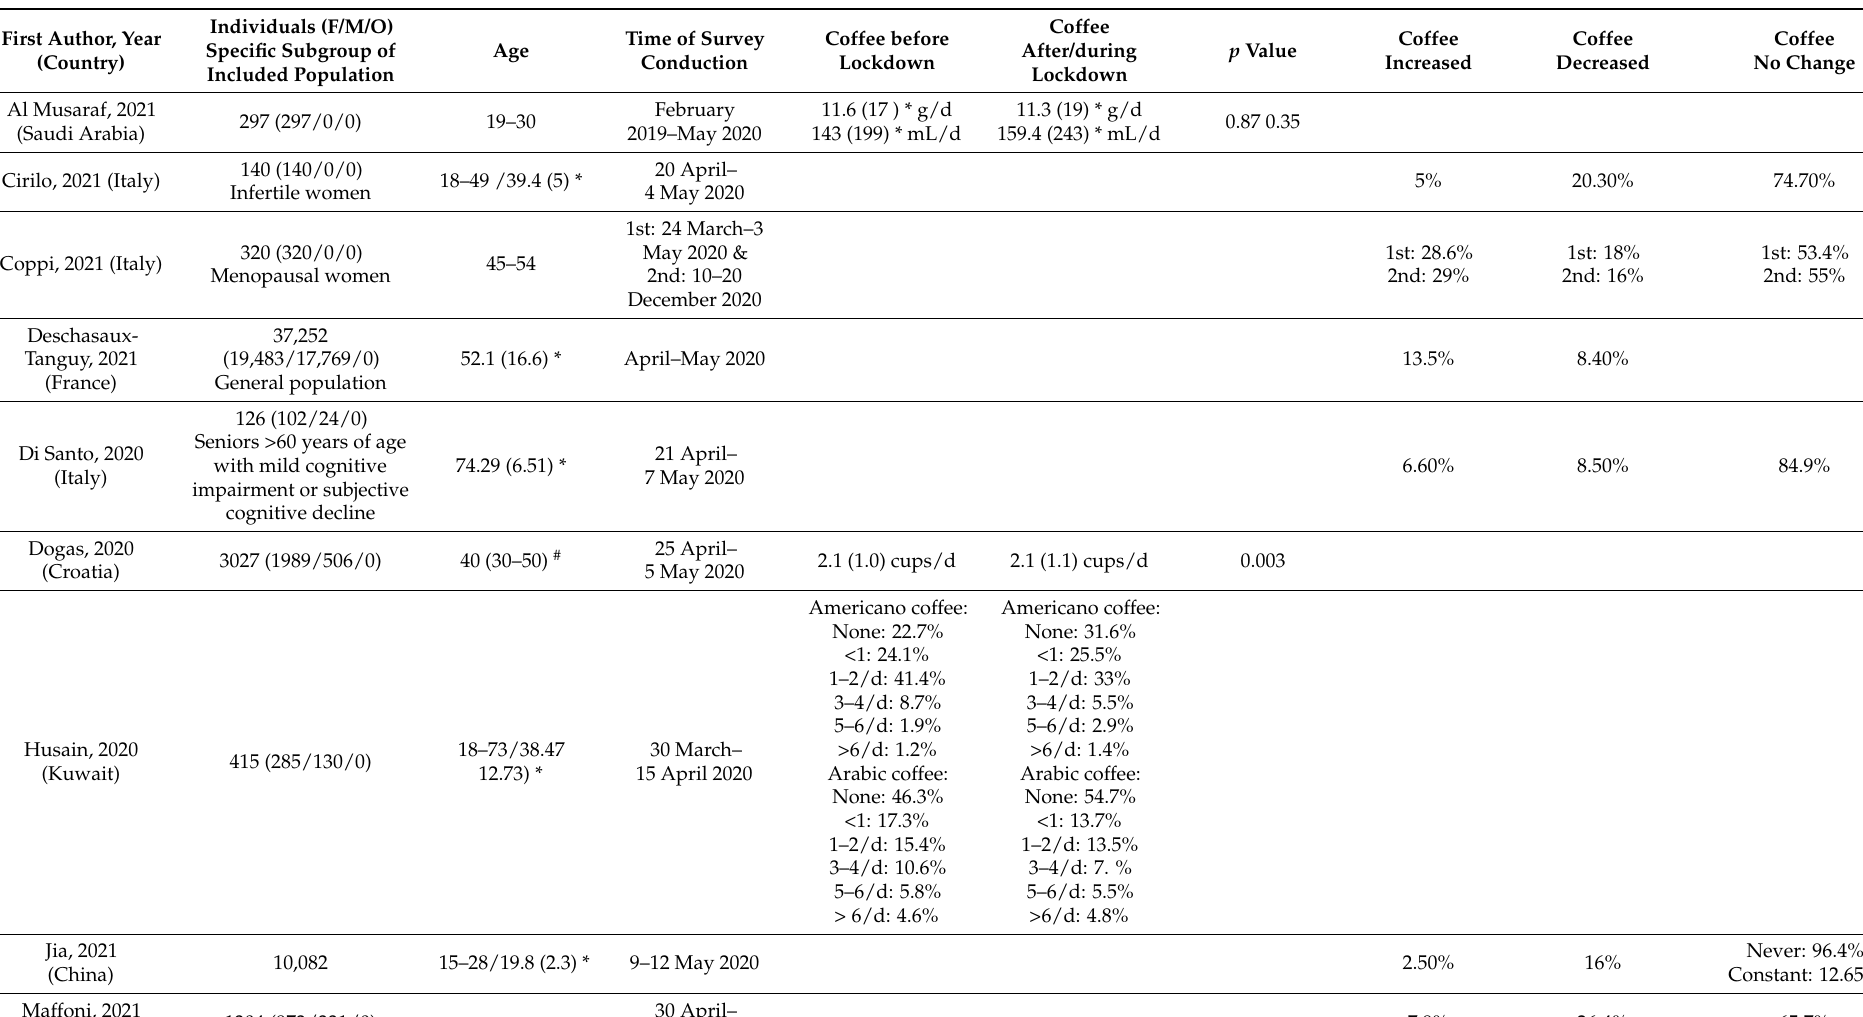
Table 1. Characteristics of Included studies for coffee consumption and relevant info before and after/during